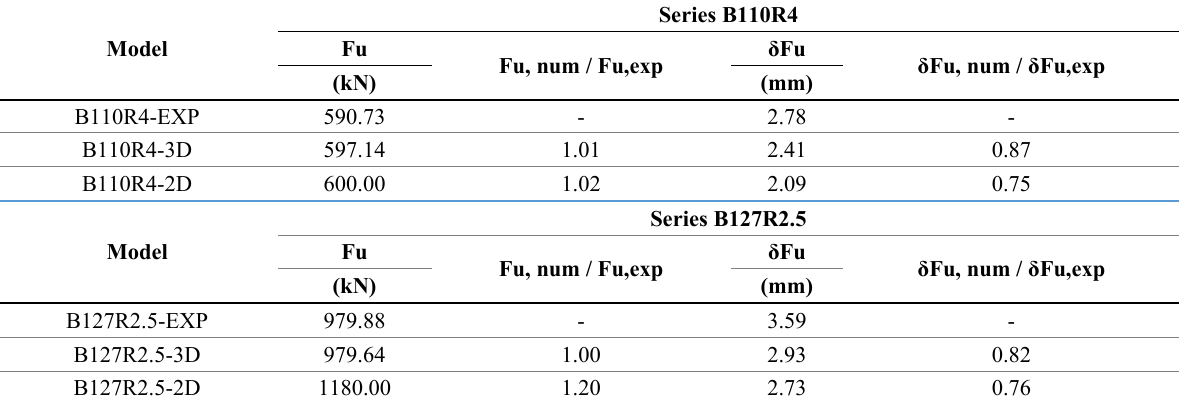
Table 5. Failure loads and vertical displacements of the models of series B110R4 and B127R2.5